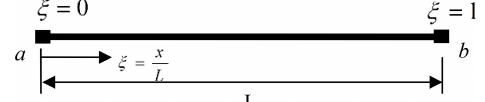
Figure 3. Definition of the dimensionless coordinate ( ξ ) of a beam